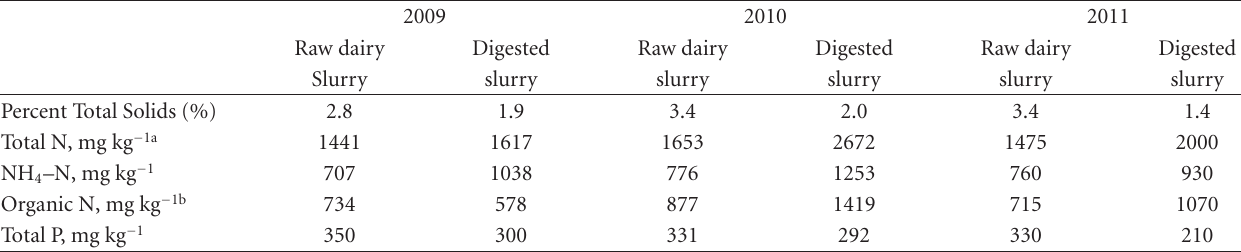
Table 3: Annual mean N and P concentrations of raw and anaerobically digested slurries applied to pasture